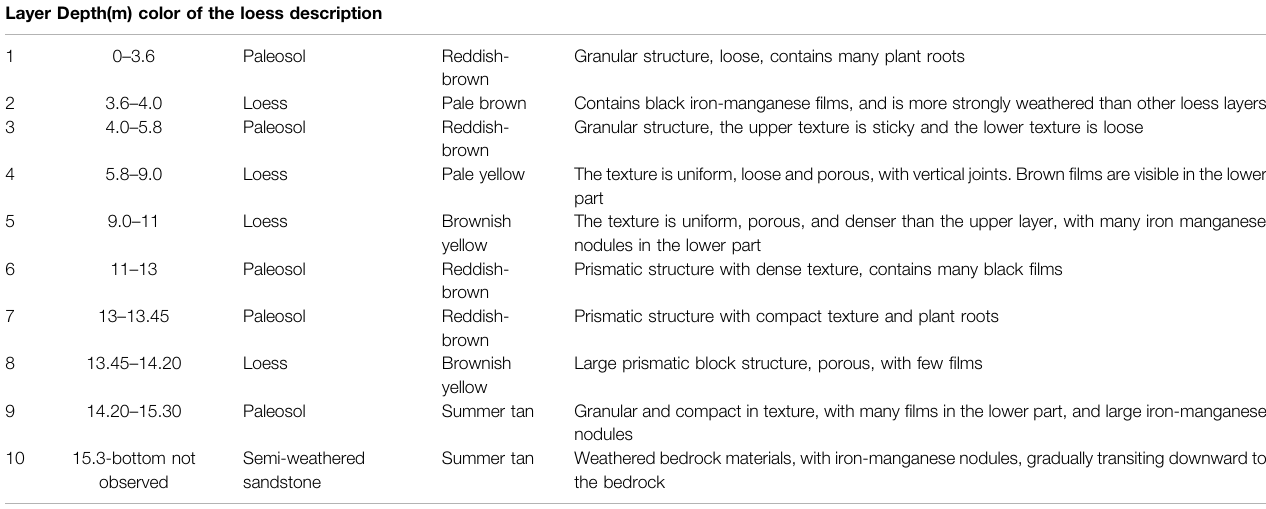
TABLE 1 | Stratigraphic description of the Xiashu loess pro fi le in XG, Nanjing. Layer Depth(m) color of the loess